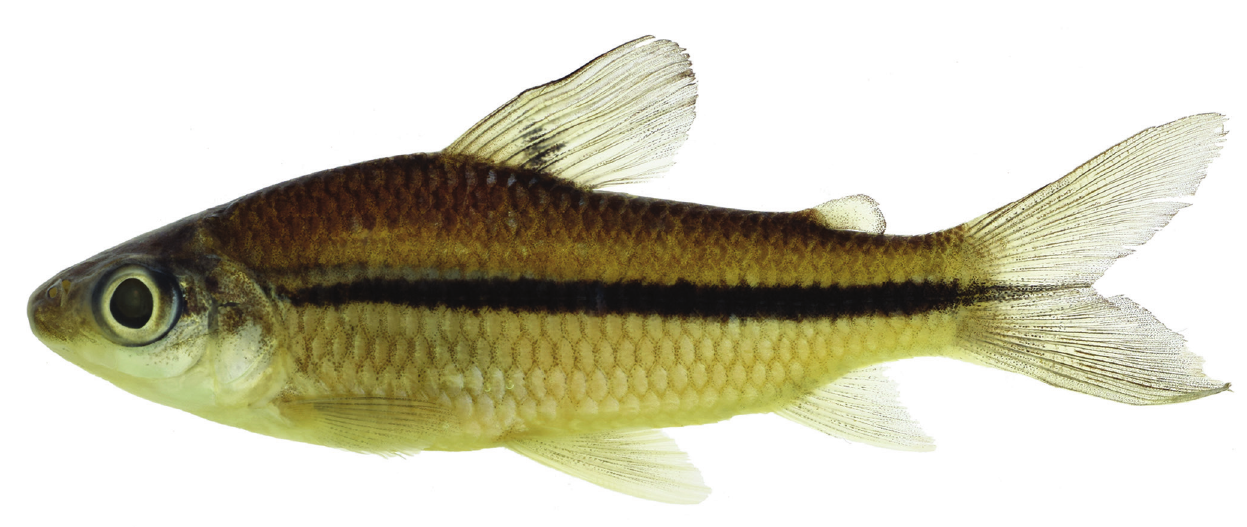
Fig. 7. Steindachnerina brevipinna , LBP 9753, 51.6 mm SL, Brazil, Mato Grosso do Sul, Nova Andradina, upper Rio